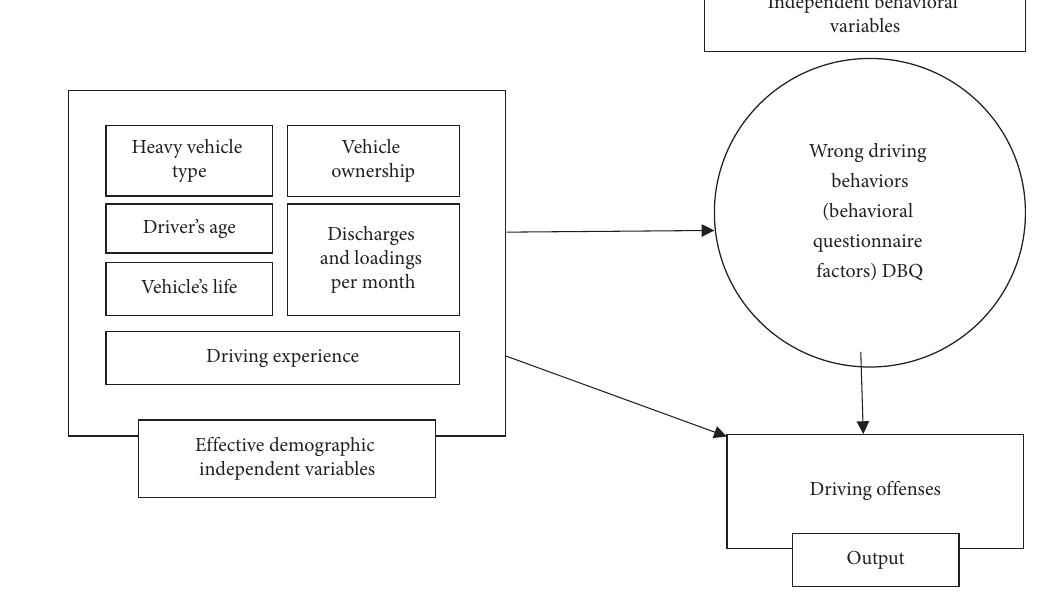
Figure 2: The exploratory working model. Table 4: Chi-square test results for independent variables.